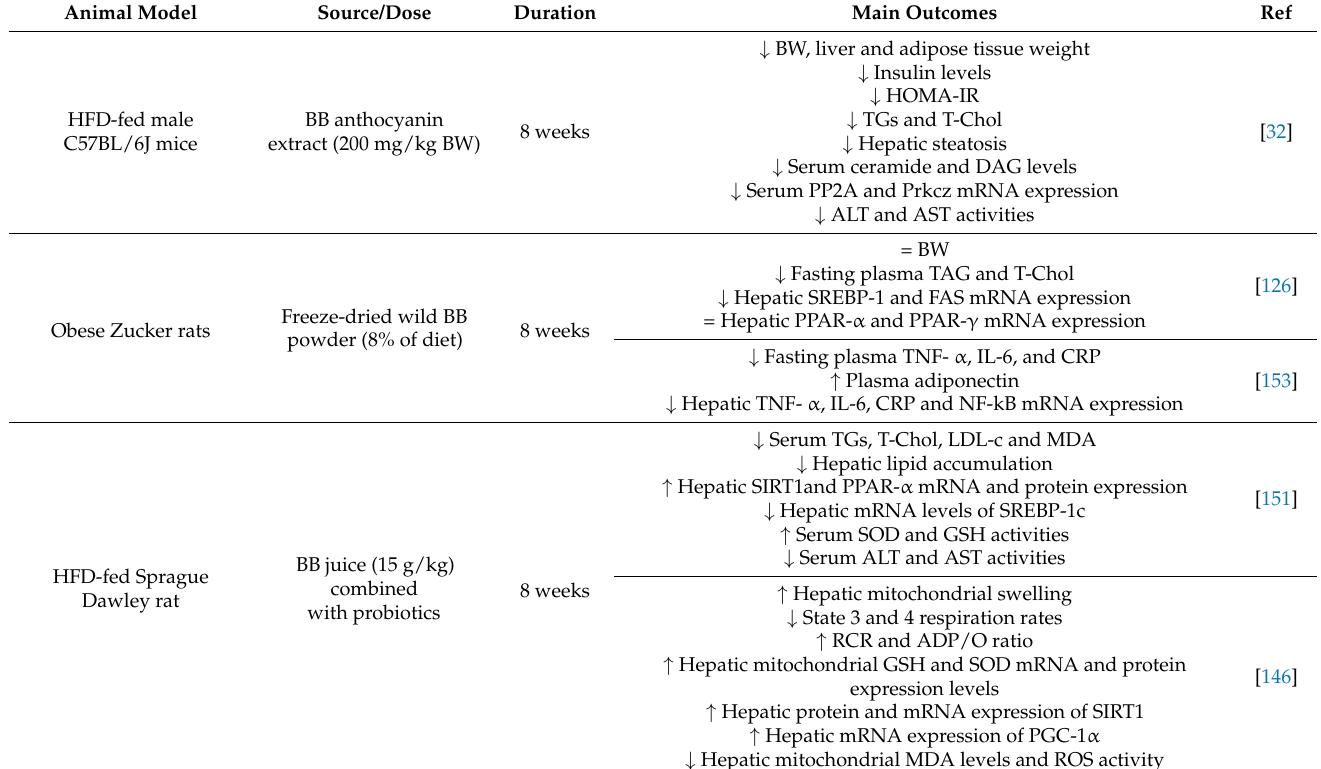
Table 2. Blueberries hepatoprotective effects in (pre)diabetic animal models. Animal